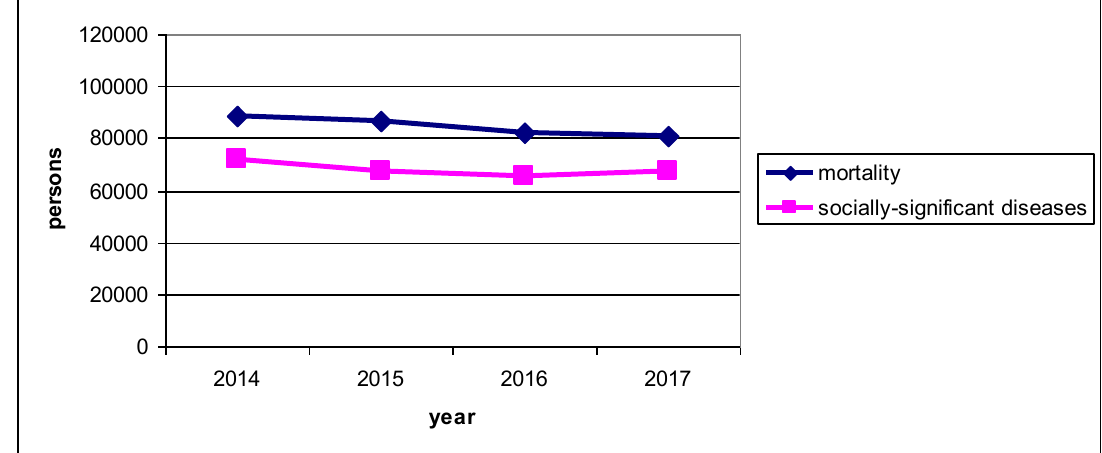
Figure 1. Total indicators of socially significant diseases (diabetes, hypertension, malignant neoplasms) and mortality in the Far Eastern Federal district for 2014–2017.